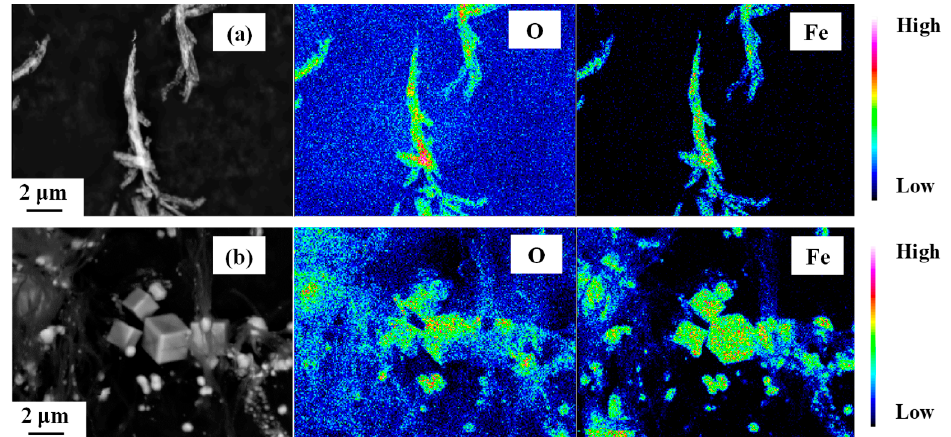
Figure 5. Backscatter electron images ( right ) and elemental maps obtained from field emission-type electron microprobe analysis at O- K ( center ) and Fe- L ( left ) edges of samples ( a ) A and ( b ) C.